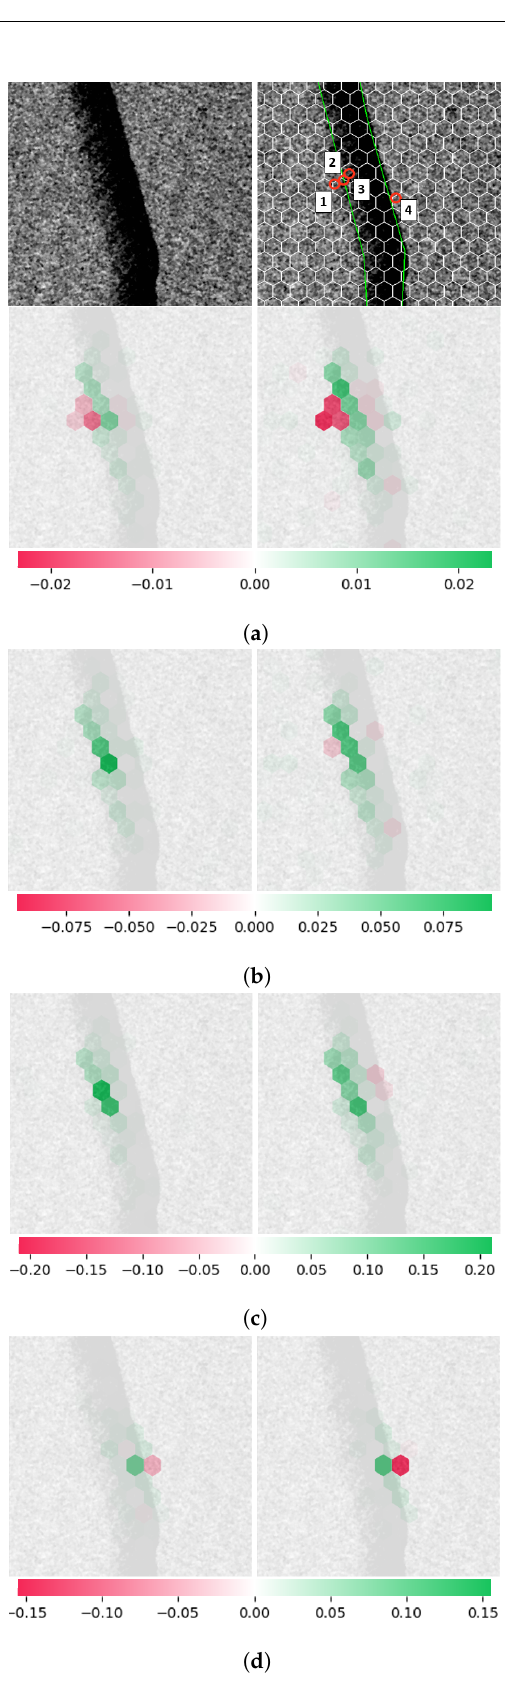
Figure 23. Results of SHAP explanation function, showing effects of slick edges on networks. ( a ) SHAP images for pixel number 1, classified as sea; ( b ) SHAP images for pixel number 2, between slick and sea; ( c ) SHAP images for pixel number 3, classified as slick; ( d ) SHAP images for pixel number 4, between slick and sea. Similar legend to Figure